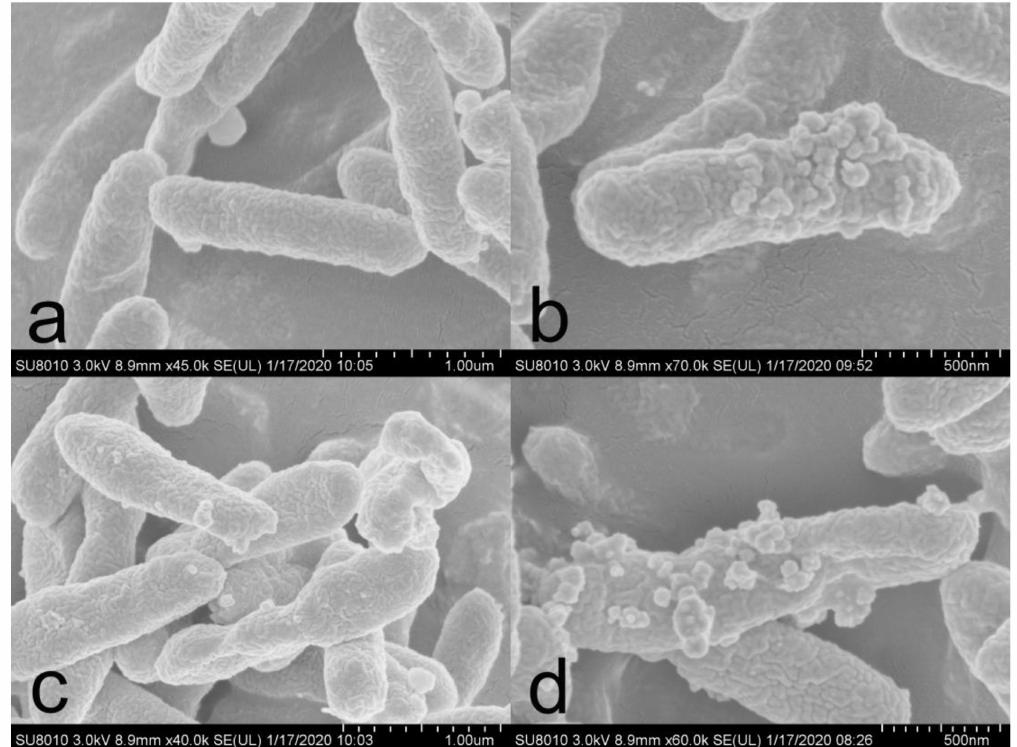
Figure 7. SEM of Xoo. ( a ) Control group; ( b – d ) treated by